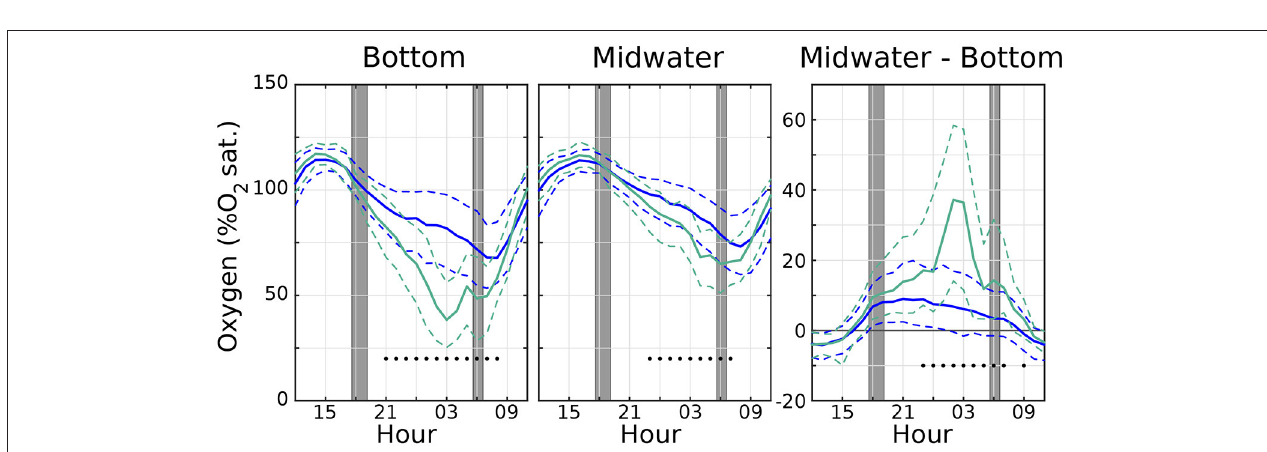
FIGURE 3 | Distribution of hourly O 2 values (in %O 2 atmospheric saturation) showing median values (solid lines), as well 25/75th percentiles (dashed lines) for (left) bottom and (middle) midwater sensors, with a (right) distribution of their differences. Blue lines use the entire O 2 timeseries, and green teal lines are calculated using only days with hypoxia. Black dots indicate hours where the median of hypoxic O 2 values is significantly different from the median of all the O 2 values according to the Wilcoxon Rank Sum test. Dark gray line in right panel shows O 2 difference equal to 0. Time axis is centered at midnight (00 h). Gray regions indicate range of times for sunset and sunrise throughout the sampling